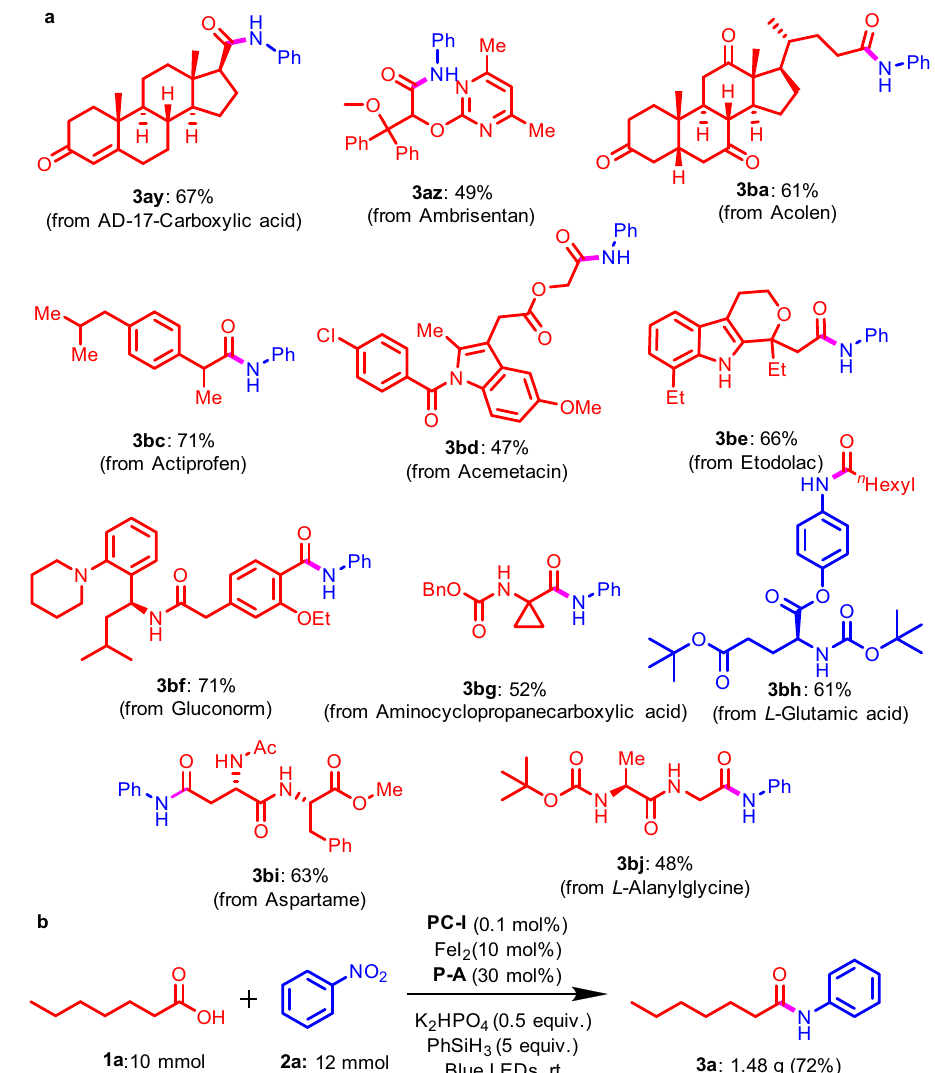
Fig. 4 Synthetic application. a Late-stage Umpolung amidation of complex molecules. Standard conditions for late-stage modi fi cation: carboxylic acids 1 (0.2 mmol), nitroarenes 2 (0.24 mmol), PC-I (1 mol%), P-A (30 mol%), FeI 2 (15 mol%), K 2 HPO 4 (0.5 equiv), PhSiH 3 (1 mmol), MeCN (4 ml), blue LEDs, 24-60h. b Gram-scale test with 0.1 mol% photocatalyst. Standard conditions for gram-scale experiment: n -heptanoic acid 1a (10 mmol), nitrobenzene 2a (12 mmol), PC-I (0.1 mol%), P-A (30 mol%), FeI 2 (10 mol%), K 2 HPO 4 (0.5 equiv), PhSiH 3 (5 equiv), MeCN (100 ml), blue LEDs, 48